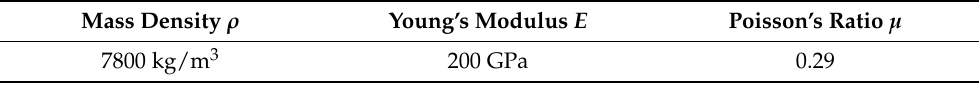
Table 1. Material parameters of the railway steel as input for the simulation.